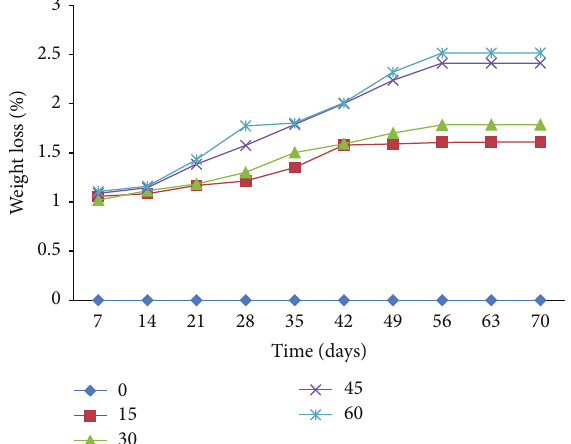
Figure 6: Weight loss at different RPIF Loadings.